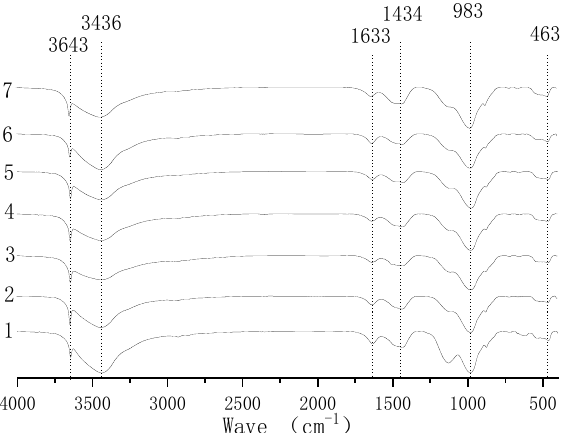
Figure 4. FTIR analysis of EPS concrete in groups 1–7.